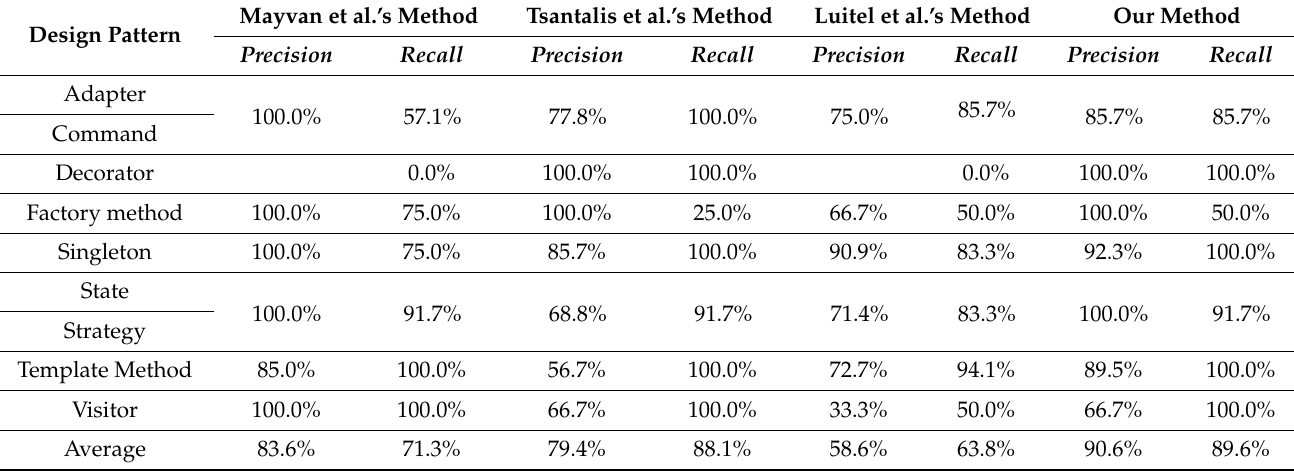
Table 6. The precisions and recalls in JRefactory